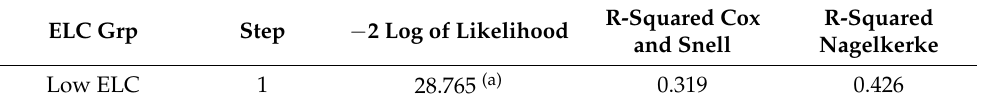
Table 4. Summary of the Model.